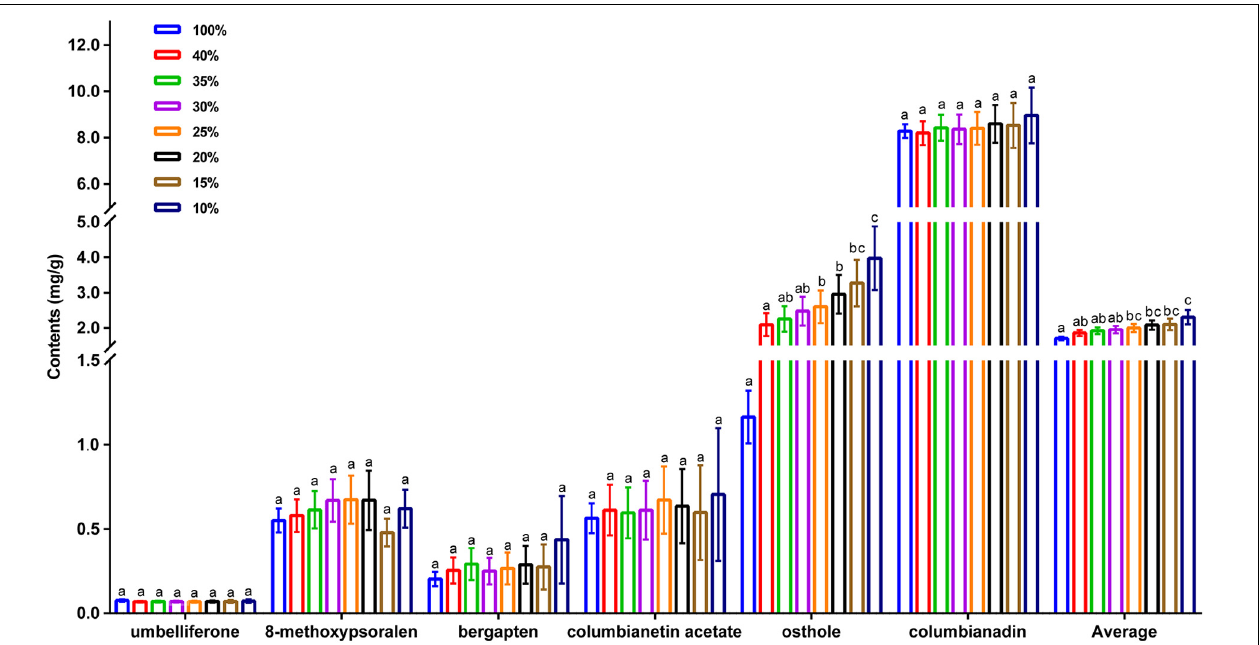
FIGURE 4 | The average content of individual coumarin, average content of total coumarins of the original germplasm and seven preliminary core collections. 100% represents the original germplasm, 40% ∼ 10% represent seven preliminary core collections with different sampling ratios. X -axis represents different species of coumarins, Y -axis represents content